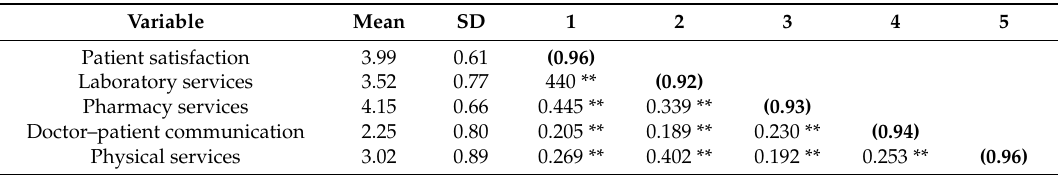
Table 4 for a summary of the descriptive statistics and the zero order correlations and alpha coefficients. Table 4. Descriptive statistics, Pearson’s correlations, and reliability coefficients among